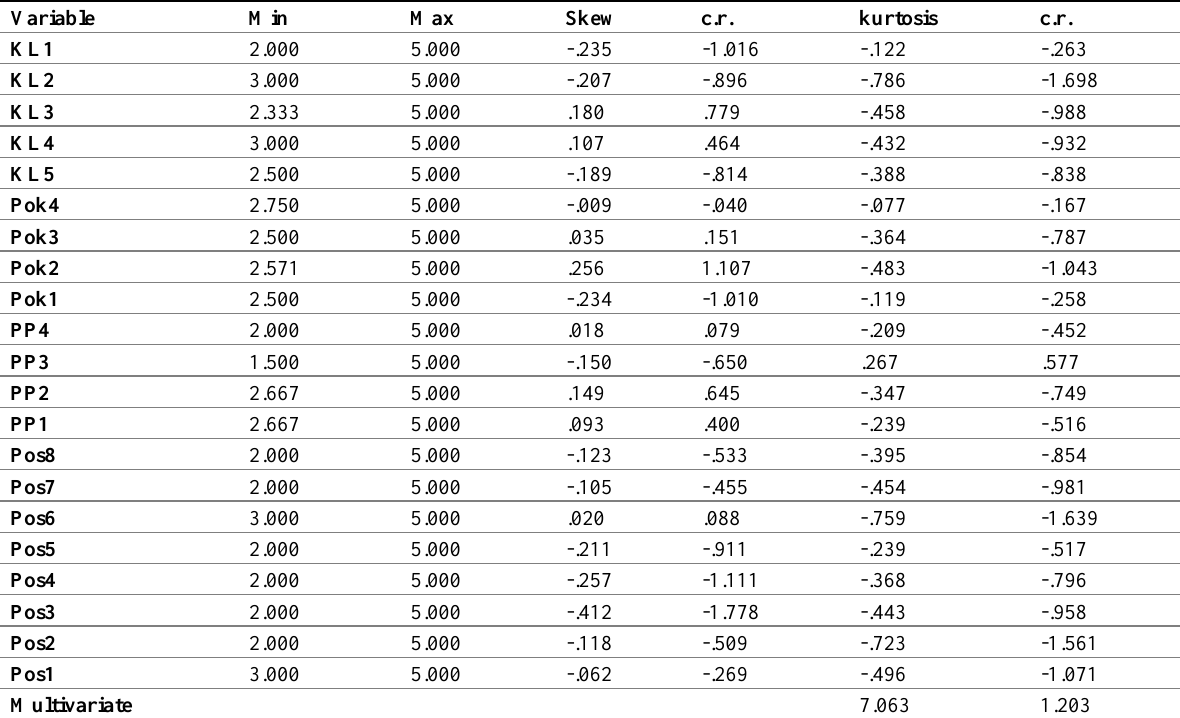
Table 2 : Result of Normality Test